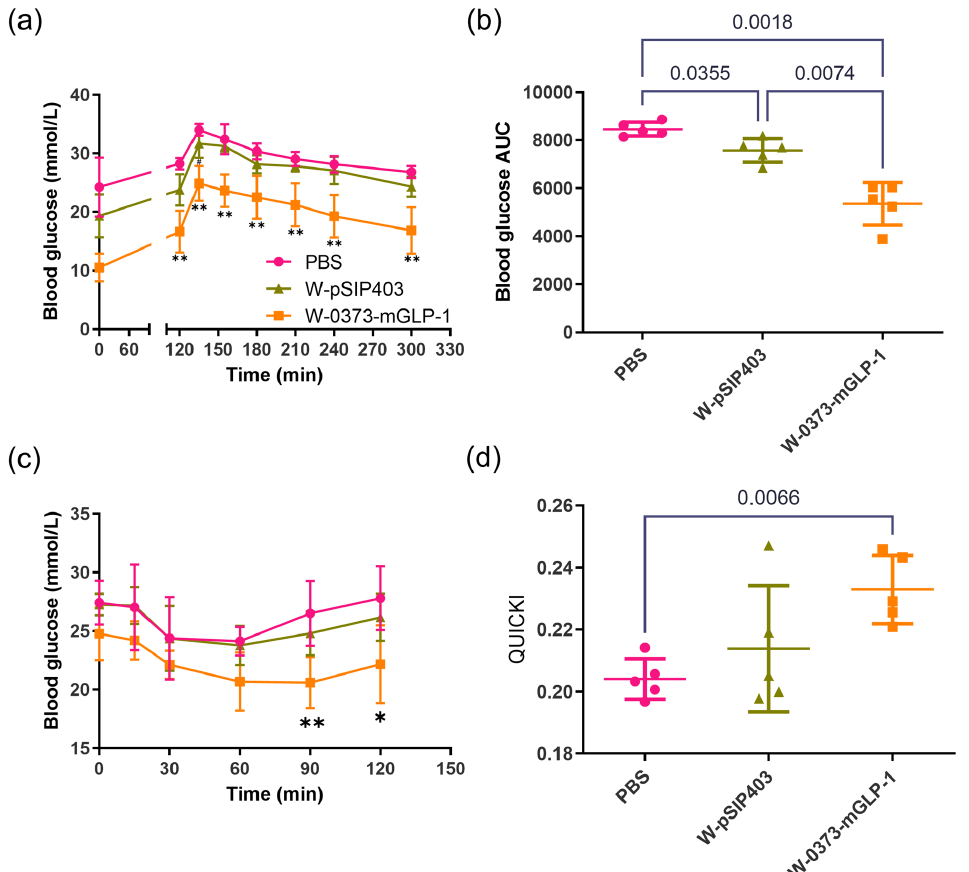
Figure 6. Effects of 14-day W-0373-mGLP-1 administration on ( a ) oral glucose tolerance test (OGTT) and ( b ) corresponding integrated glucose concentrations (AUCs), ( c ) insulin tolerance test (ITT) and ( d ) quantitative insulin sensitivity check index (QUICKI). All data are represented as mean ± SD. * p < 0.05, ** p < 0.01 compared with PBS group.